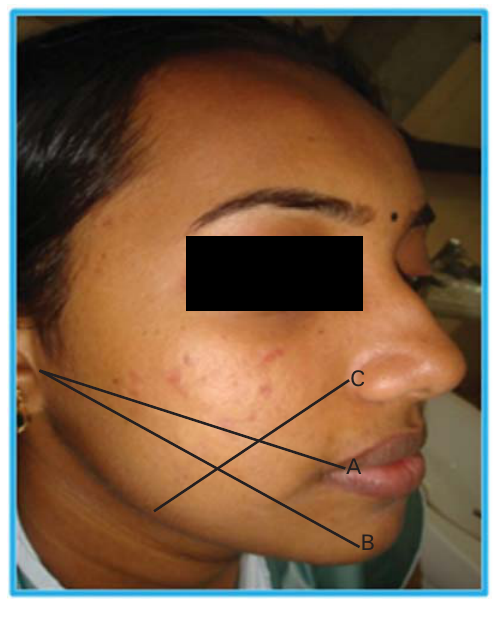
Figure 1. Showing measurements of facial contour (swelling) between the (cid:2) ve references points: (A) tragus to corner of mouth, (B) tragus to the pogonion and (C) mandibular angle to ala of the nose to generate a block randomization schedule